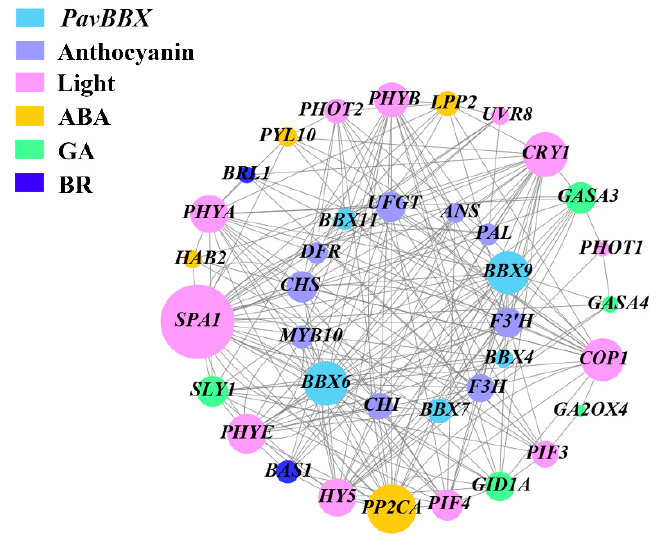
Figure 7. Co-expression network analysis of BBX , anthocyanin biosynthesis, light signaling, and multiple hormone signaling genes in bicolored cherry fruits.